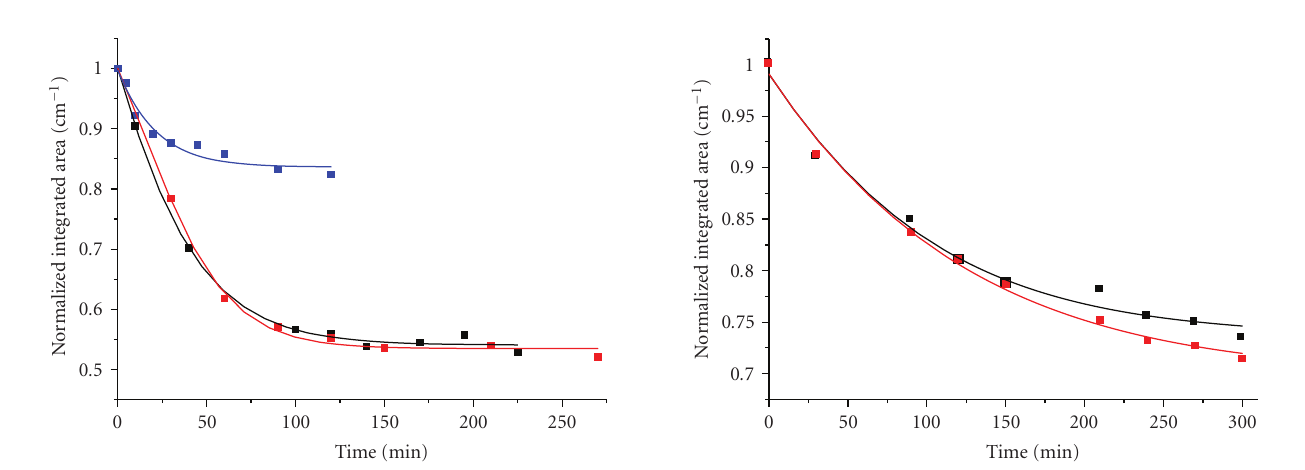
Figure 7: Visible stearic acid tests for TiO 2 over Ag (2 passes). First stearic acid run , additional stearic acid and experiment repeated , titania film .